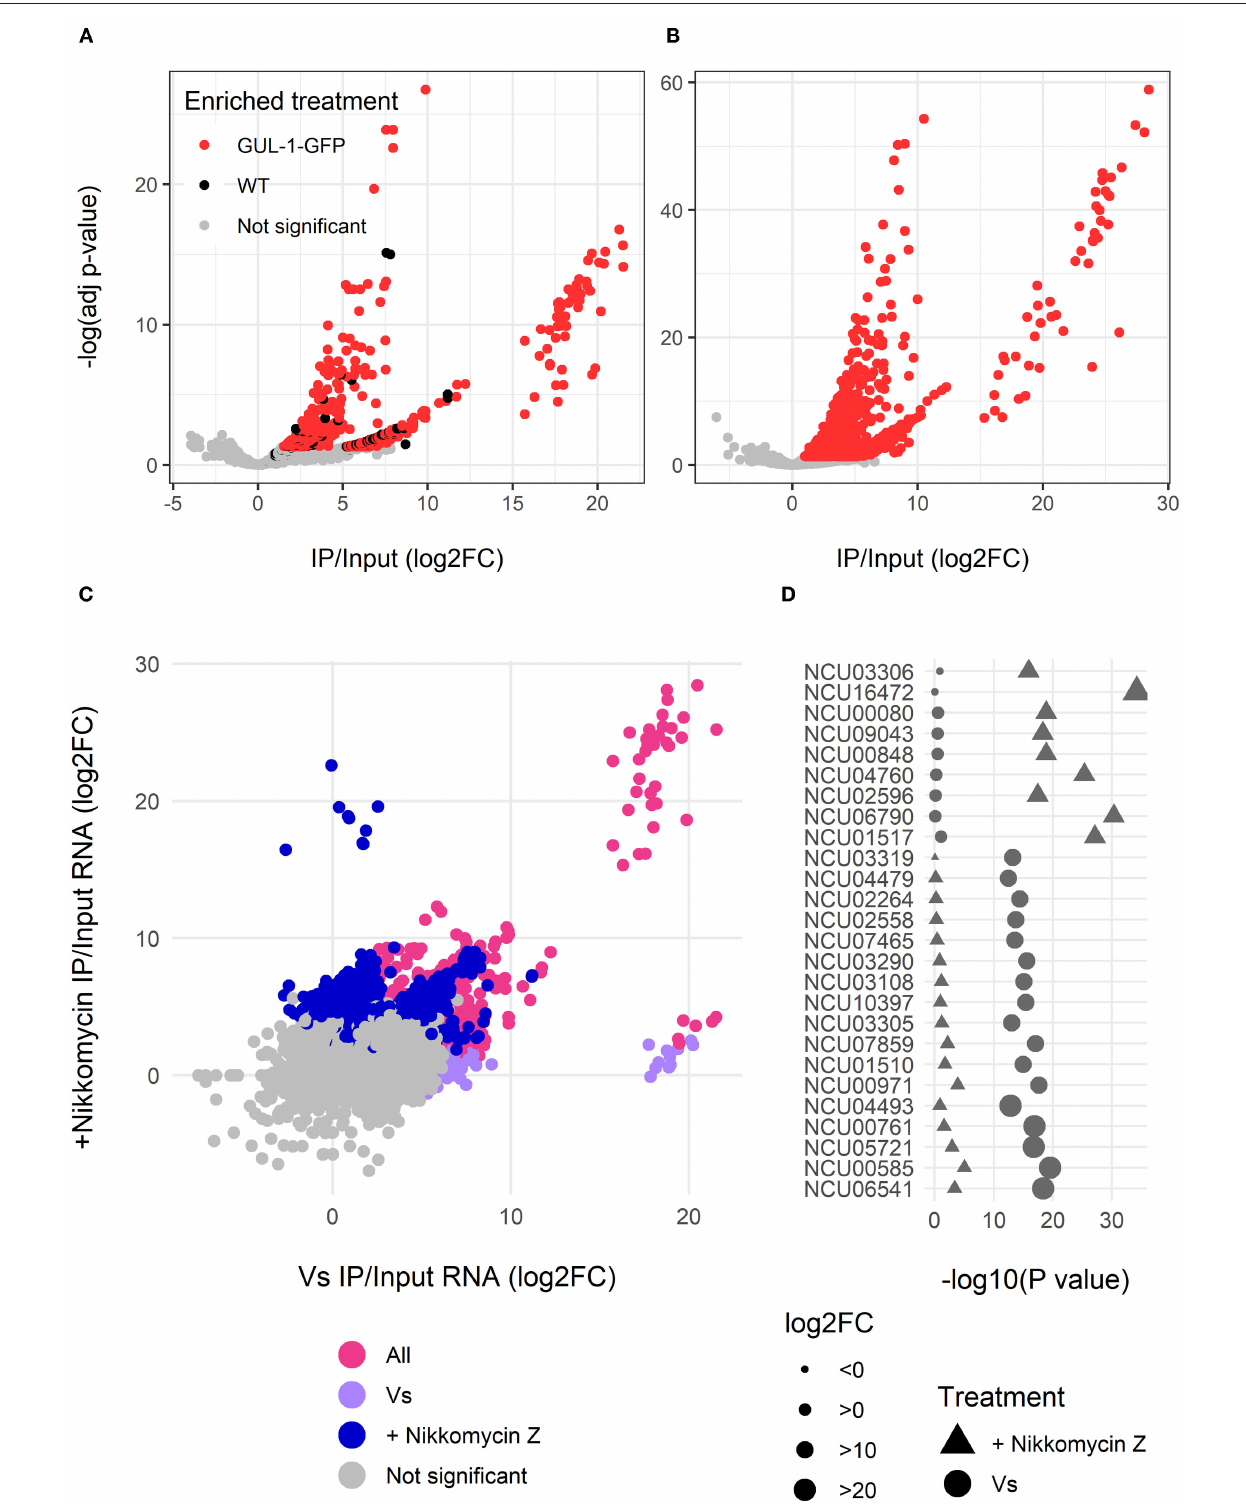
FIGURE 2 | GUL-1 can interact with over 2,000 mRNAs. RNAseq analysis of transcripts immunprecipitated with GUL-1-GFP. Log2 fold-change of GFP pull-down enriched RNAs were compared to wild-type and –Log (adjusted P -value) of (A) standard growth medium (Vs) and (B) Nikkomycin Z treatment. Colors indicate the genes significantly enriched in GFP-labeled GUL-1 (red), but not enriched in wild-type GUL-1 IPs (in black). (C) A comparison of enrichment (log2FC) between